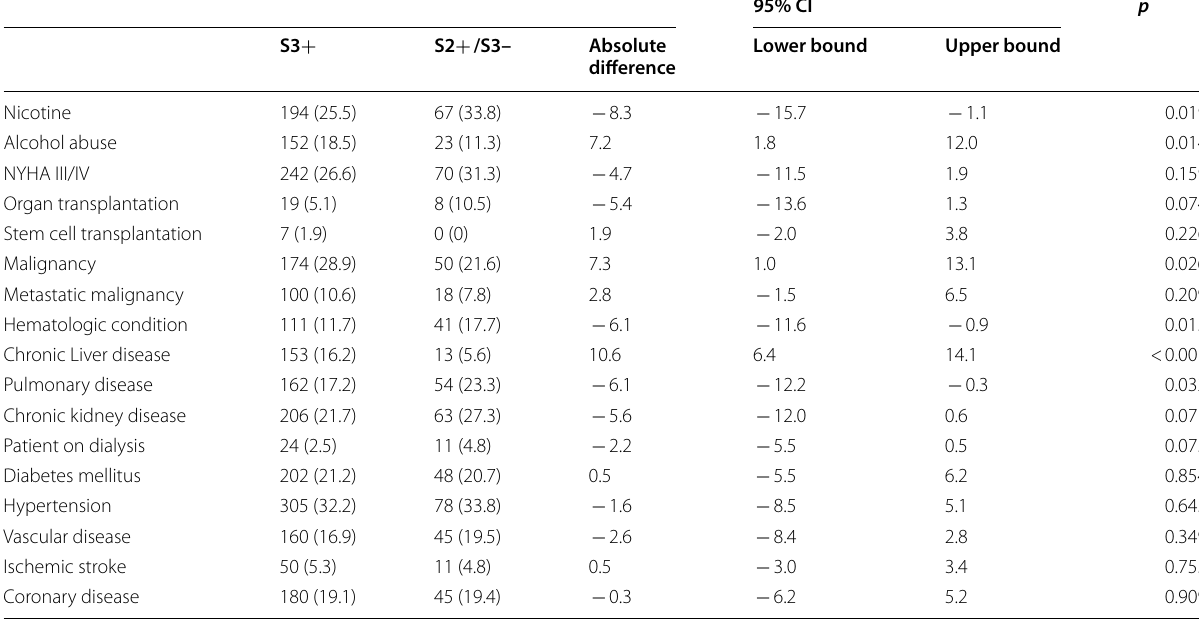
All values are expressed as median (IQR) or n (%). NYHA: New York Heart Association